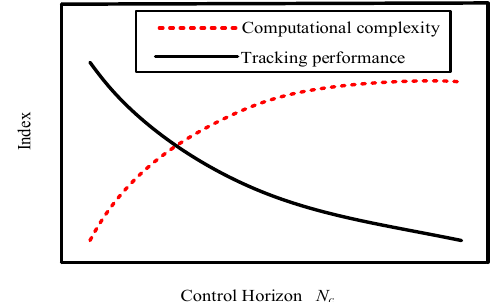
Figure 2. The relationship between tracking performance, computational complexity and control horizon.